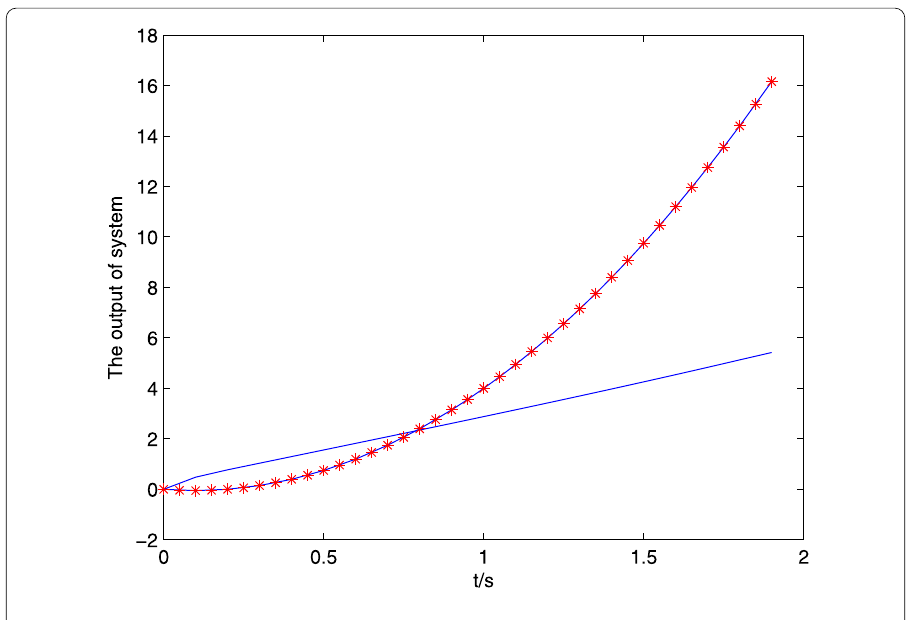
Figure 5 ∗∗∗ denotes the desired trajectory, — denotes the output of the system.